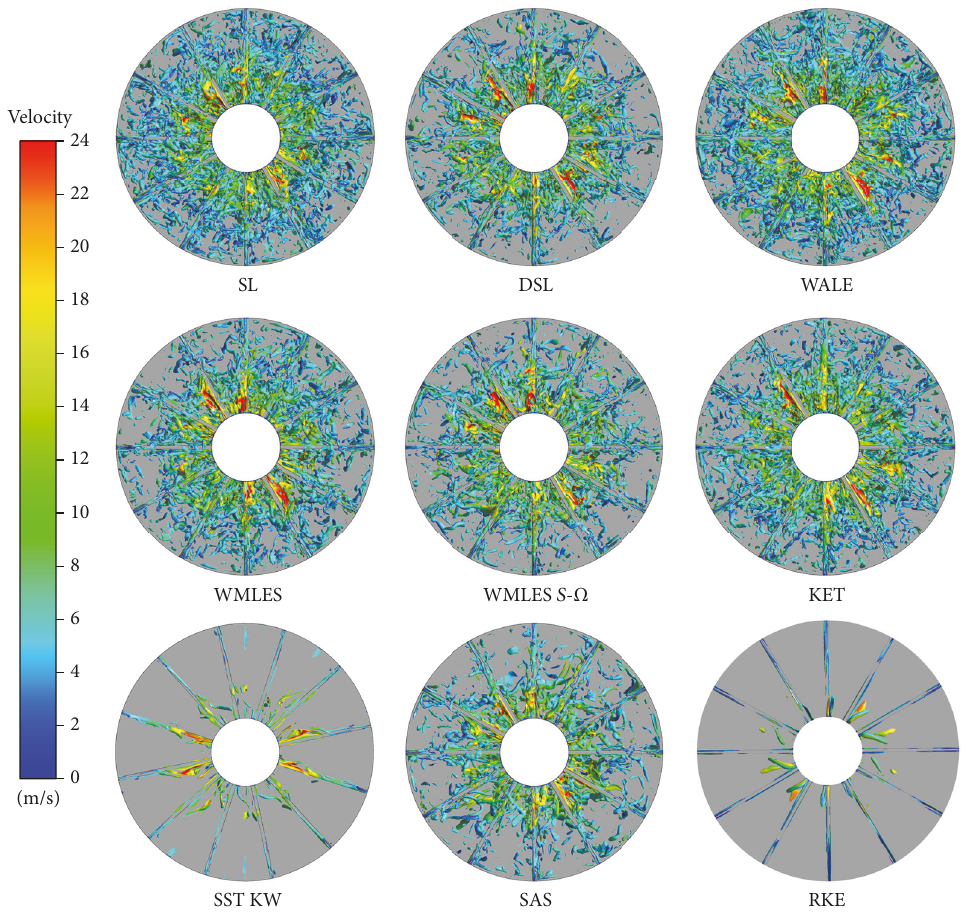
Figure 6: Vortex structures in whole flow